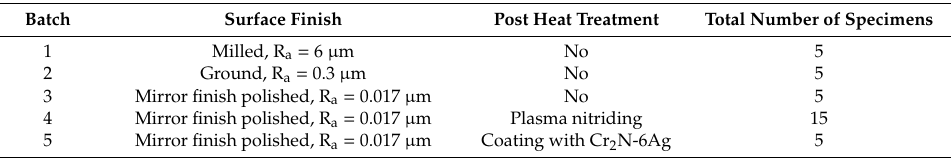
Table 1. Characterization of specimen batches used in the experimental works. Batch Surface Finish